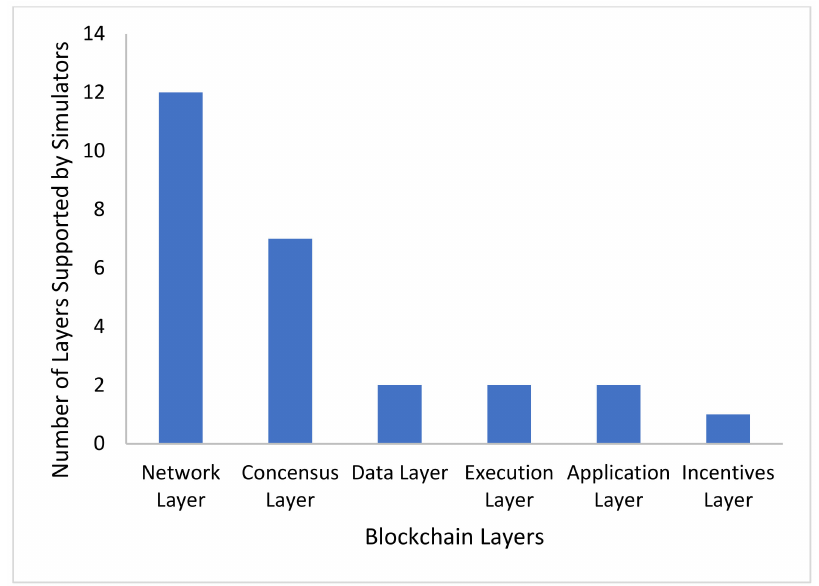
Figure 5. The number of blockchain layers supported by the 15 simulators versus the blockchain